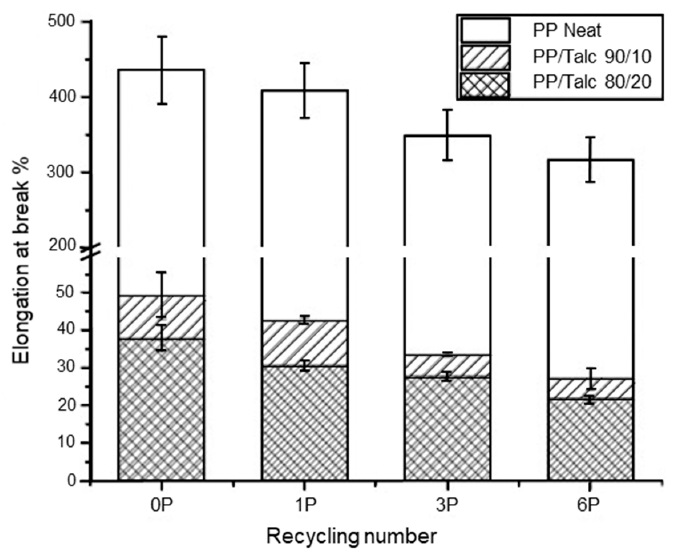
Figure 10. Elongation at break of non-recycled and recycled neat PP and PP/talc composites. Repro- duced with permission [213].